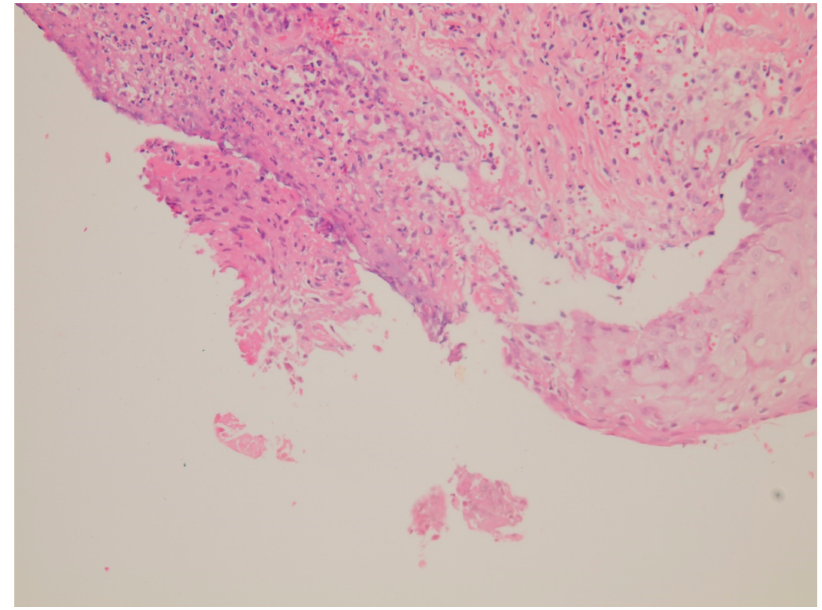
Figure 2. Ulcer with necrotizing inflammation and abcess formation over the dermis (hematoxylin and eosin stain, 200 × ).